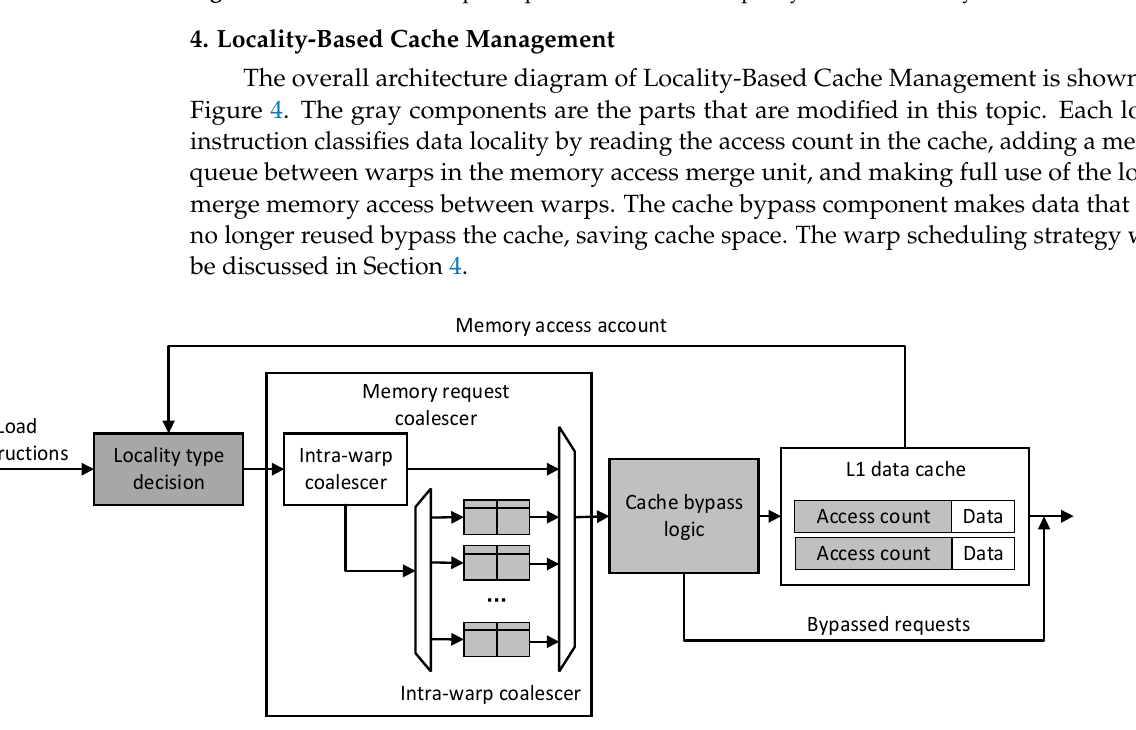
Figure 4. Overall diagram of Locality-Based Cache Management architecture.